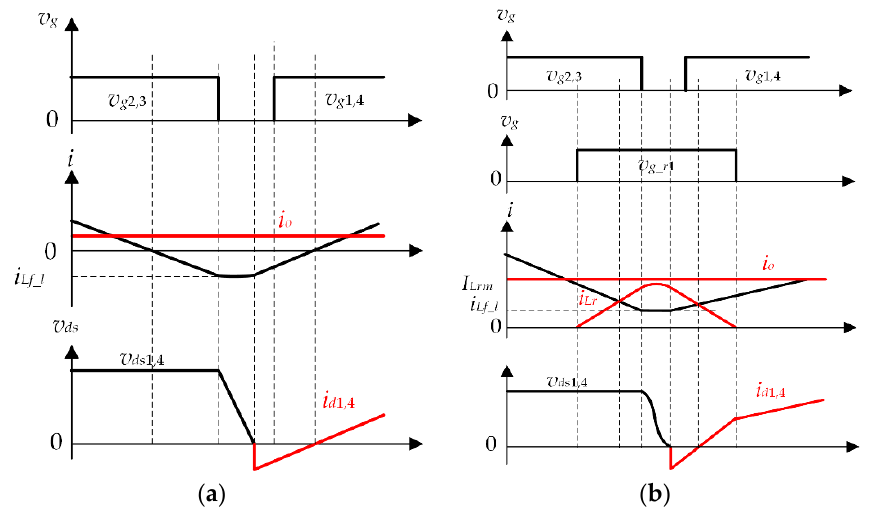
Figure 3. Key waveforms to realize the zero-voltage switching (ZVS) of S 1 and S 4 ( a ) i Lf_l < − I r_ min ; ( b ) i Lf_l > − I r_ min .